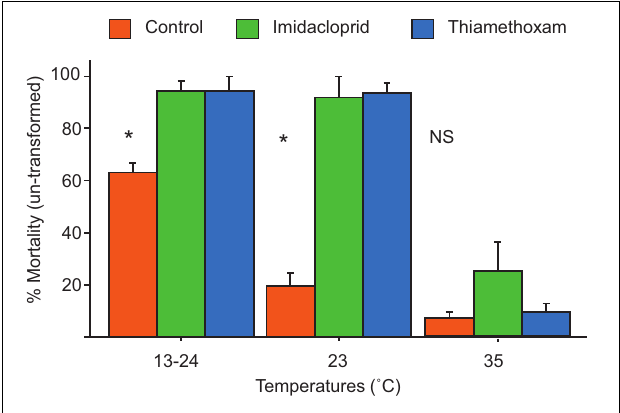
FIGURE 3 | Mean mortality (+SE) of bees exposed to the two pesticides or sugar only (control) at a varying (13 ◦ C at night and 24 ◦ C during day), constant low (23 ◦ C), or brood-nest (35 ◦ C) temperature. Control bees showed the highest, intermediate, and lowest mortality, respectively, at 13–24 ◦ C, 23 ◦ C, and 35 ◦ C (all pairwise comparisons significant, t -test, P < 0.05). The two pesticides showed similar high mortality at the two lower temperatures (different from the control, P < 0.01); but at 35 ◦ C, there was no significantly difference in mortality among the three treatments ( P > 0.05). Statistics done on transformed data but figure here presented un-transformed data. * Denotes significant difference ( P < 0.05) between the control and the two pesticides with Fisher’s Protected Least Significant Difference